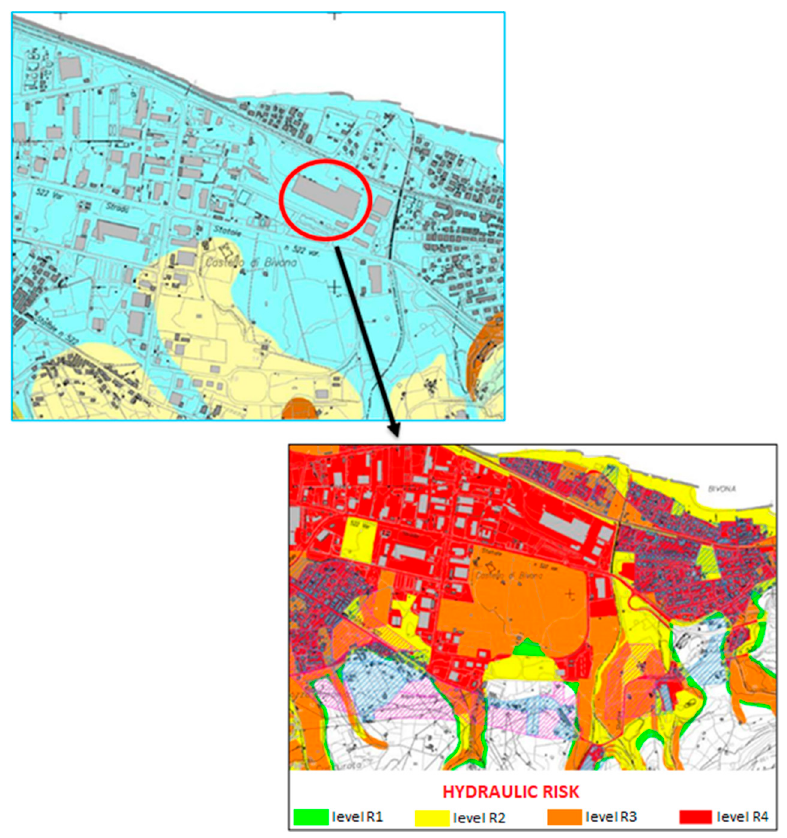
Figure 2. The geolithological map, with the hydraulic risk levels (R#, # = 1, …, 4) indicated.